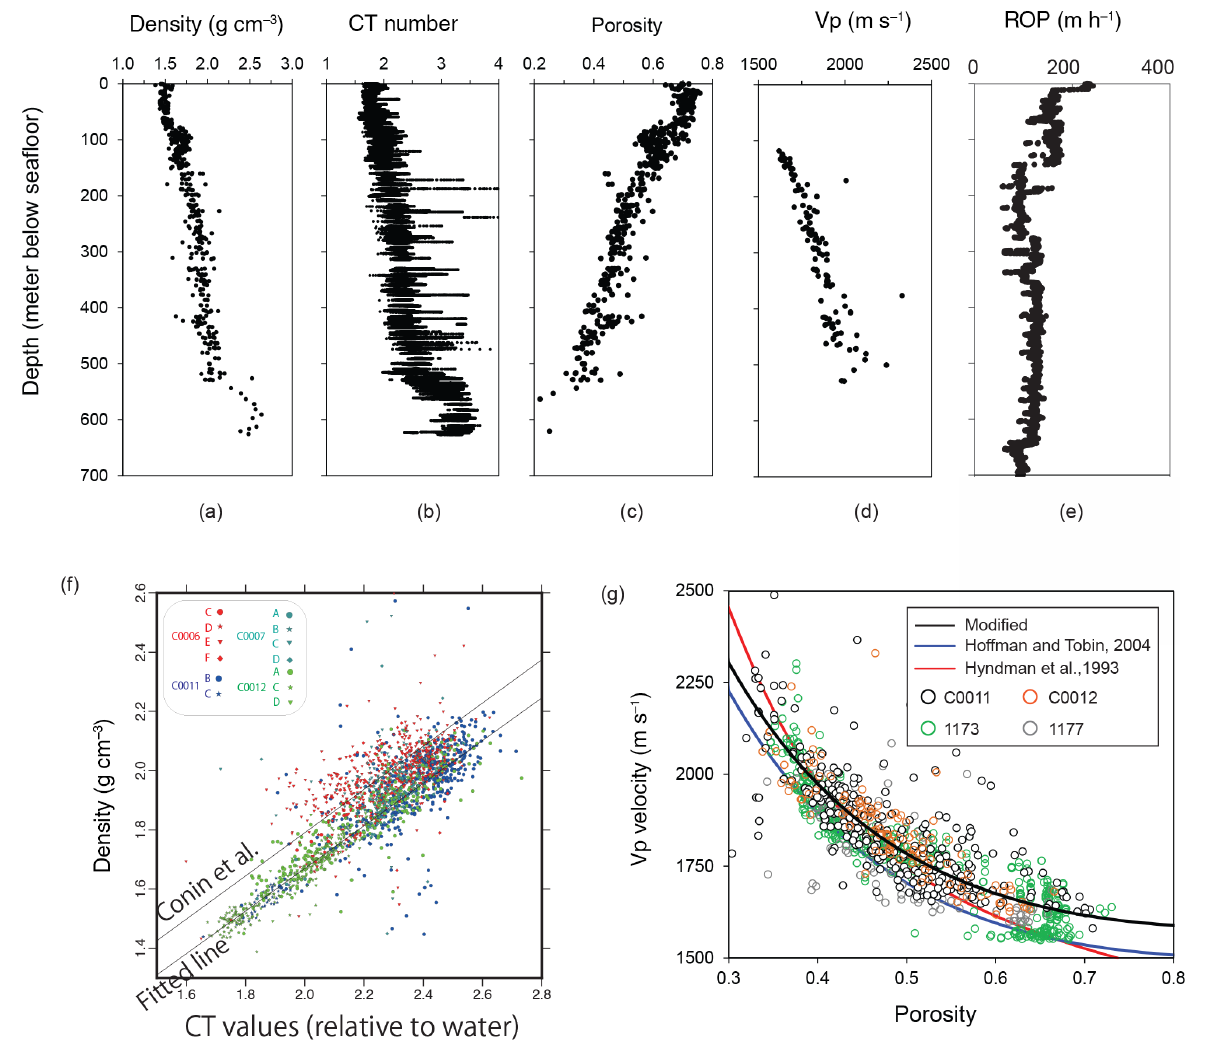
Figure 5. (a–e) Density, CT number, porosity, P-wave velocity ( V P ), and rate of penetration (ROP) along depth at Site C0012. Density, porosity and V P data are from discrete samples of Holes C0012A, C0012C, and C0012G. ROP is measured at Holes C0012B and C0012H. CT measurements on cores are from Holes C0012A, C, D, E, F, and G. (f) The correlation between CT value and density value at C0006, C0007, C0011, and C0012. (g) The correlation of porosity and V P at Sites C0011, C0012, 1173, and